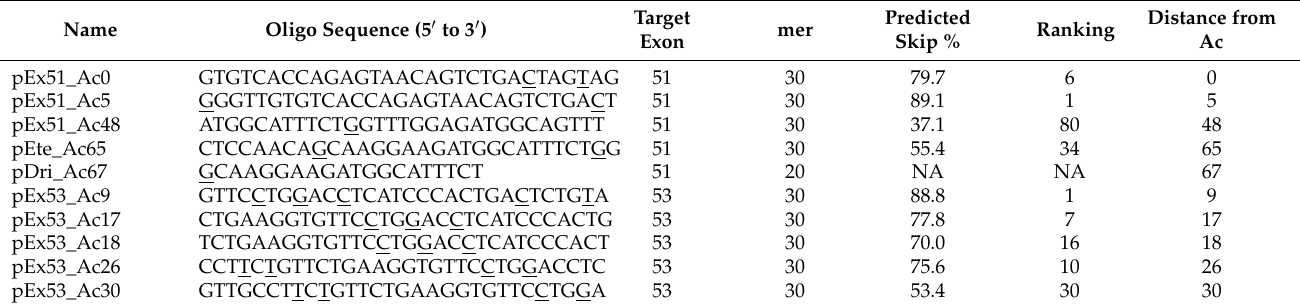
Table 1. Pig morpholino sequences and their predicted efficiency of skipping pig exon 51 or